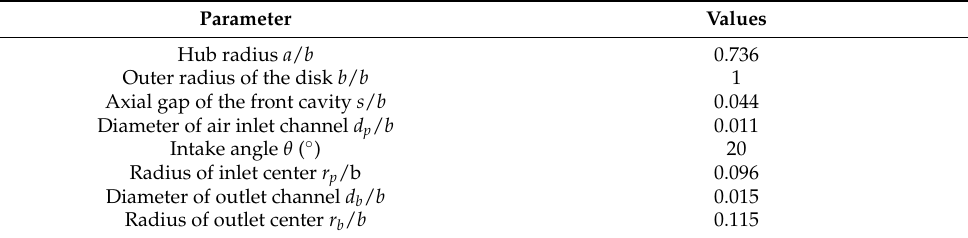
Table 1. Main geometric